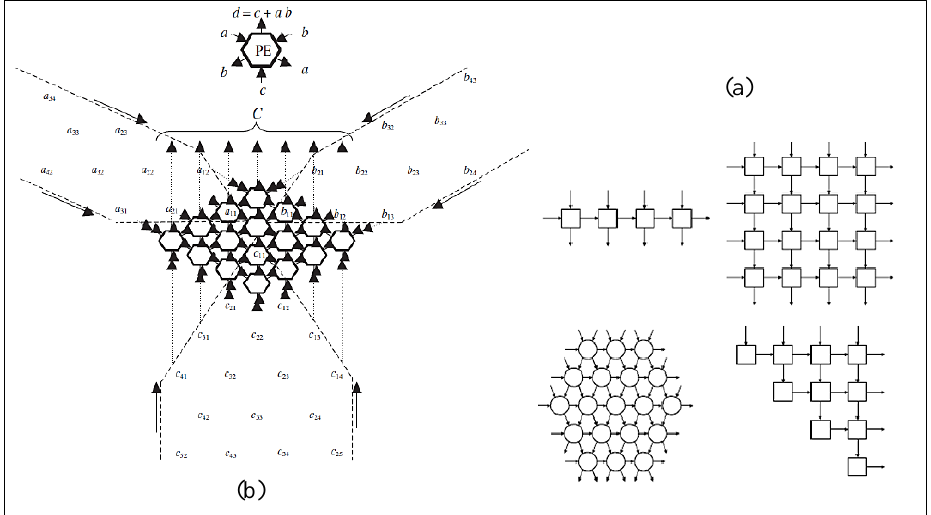
Figure 3. (a) Types of systolic array topographies: Linear, Rectangular, Hexagonal, Triangular (b) Kung Cell as a PE